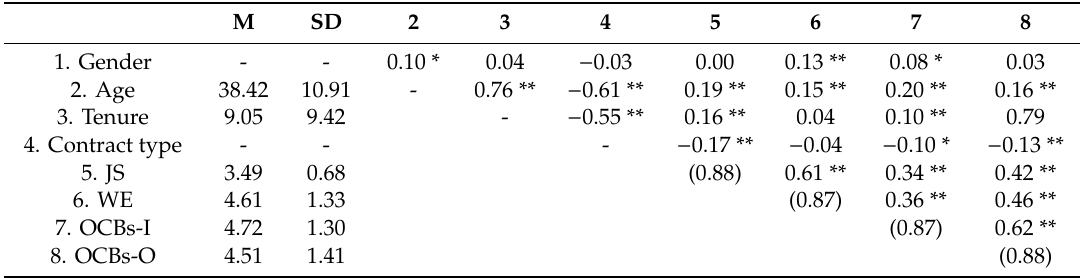
Table 1. Means, standard deviations, internal consistencies, and correlations among variables. M